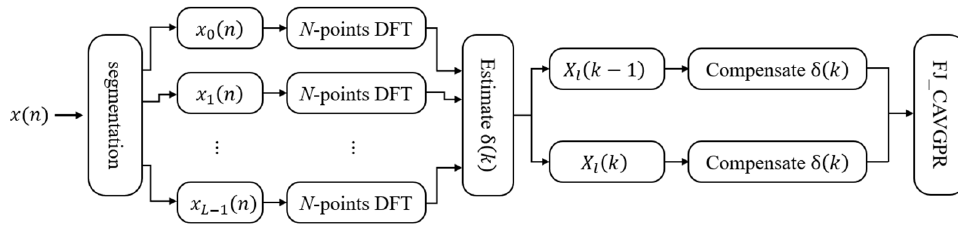
Figure 2. Schematic of the FJ_CAVGPR.